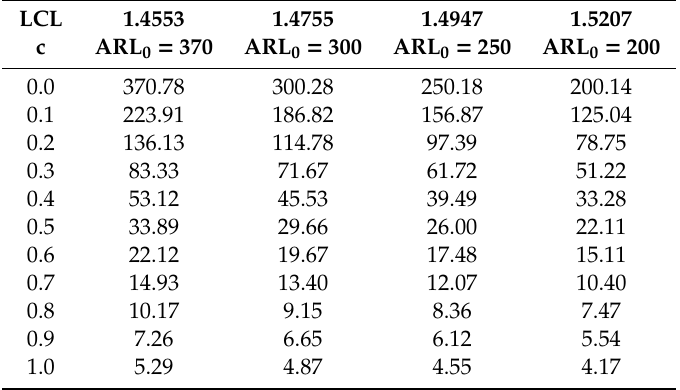
Table 1. The average run lengths (ARLs) for the proposed chart when n = 25, WD (2.8,3.5), upper